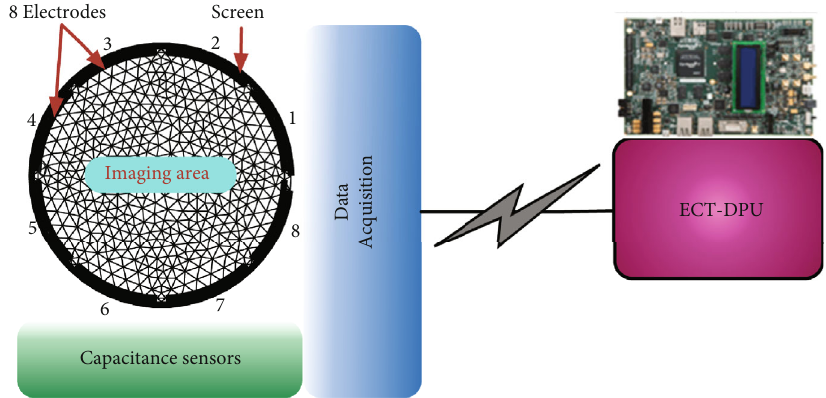
Figure 1: Wireless electrical capacitance tomography